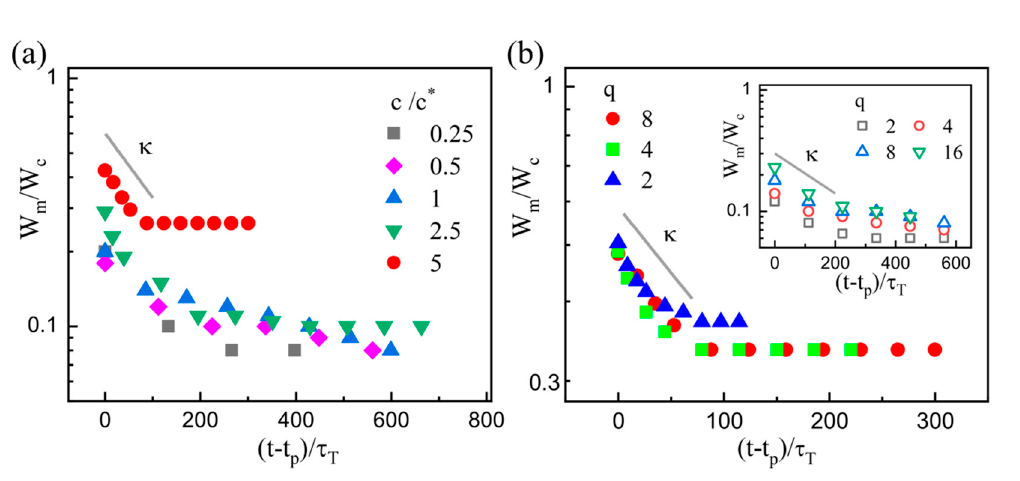
Figure 8. Plot of the dimensionless minimum width W m / W c of the dispersed filament to the dimensionless shifted time ( t − t p )/ τ T at ( a ) various c ; and ( b ) c = 5 c * . In (a), q = 8 and Q c = 80 μ L/h. In (b), Q c = 80 μ L/h. Inset: c = 0.5 c * and Q d = 10 μ L/h.